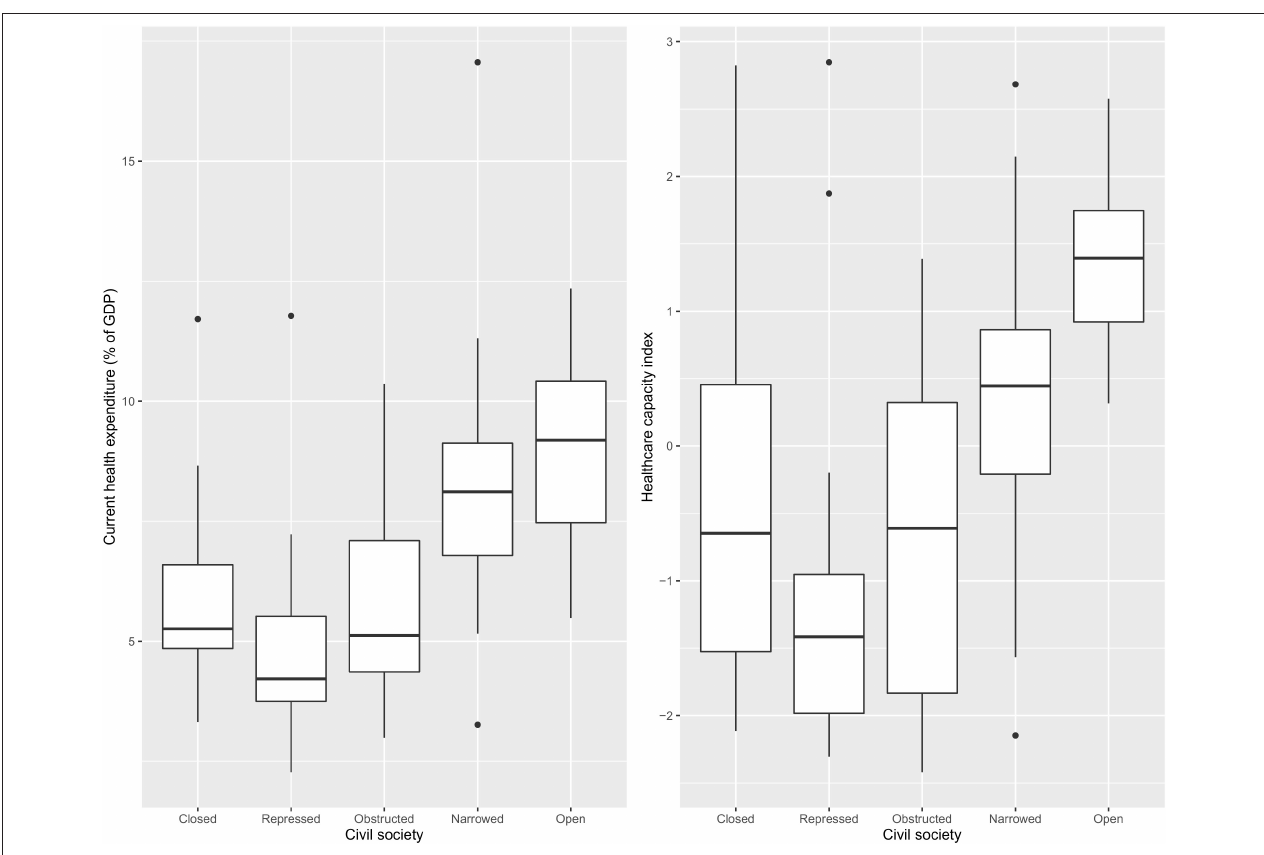
FIGURE 2 | Civil society wise distribution of health expenditure and health capacity index.